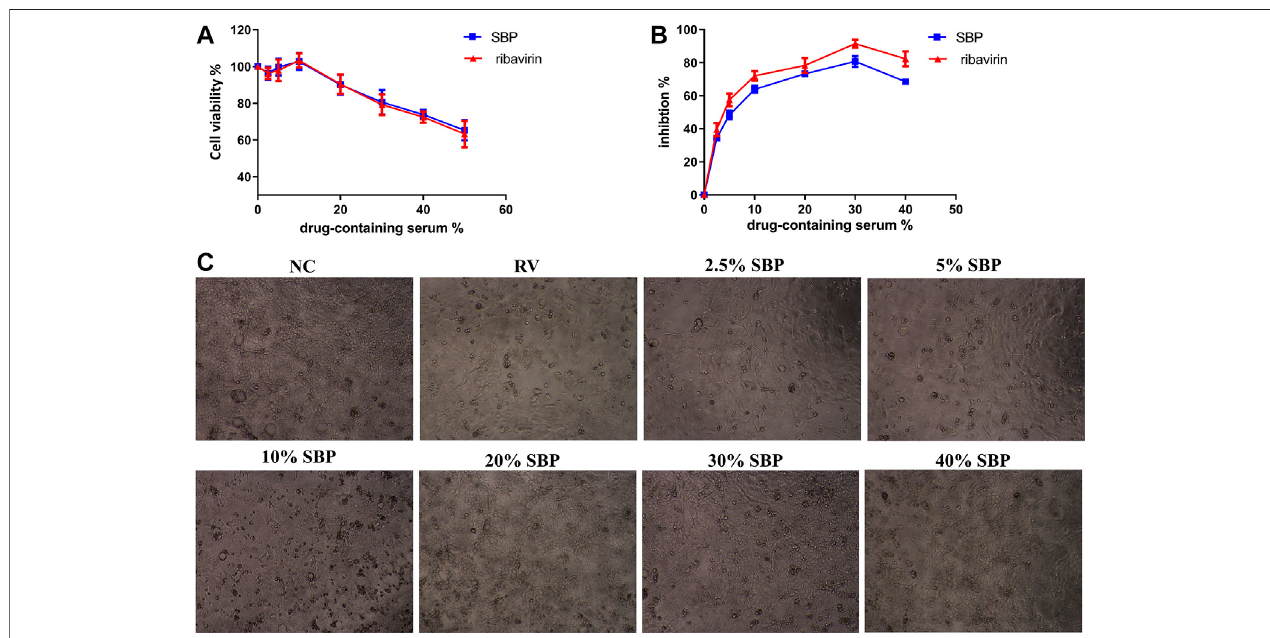
FIGURE 3 | Inhibition of RV-SA11 activity in different concentrations of SBP-containing serum in vitro (A) The cytotoxic effects of the serum on Caco-2 cells was detectedusingaCCK-8assay( n (cid:2) 3) (B) TheinhibitoryeffectsoftheserumonRV-SA11-infectedCaco-2cells.Errorbarsindicatetherangeofvaluesobtainedfromthe triplicate experiments; represented as mean ± SD of three individual experiments (C) The effect of the serum on the pathological changes in virus-infected Caco-2 cells (40 X).